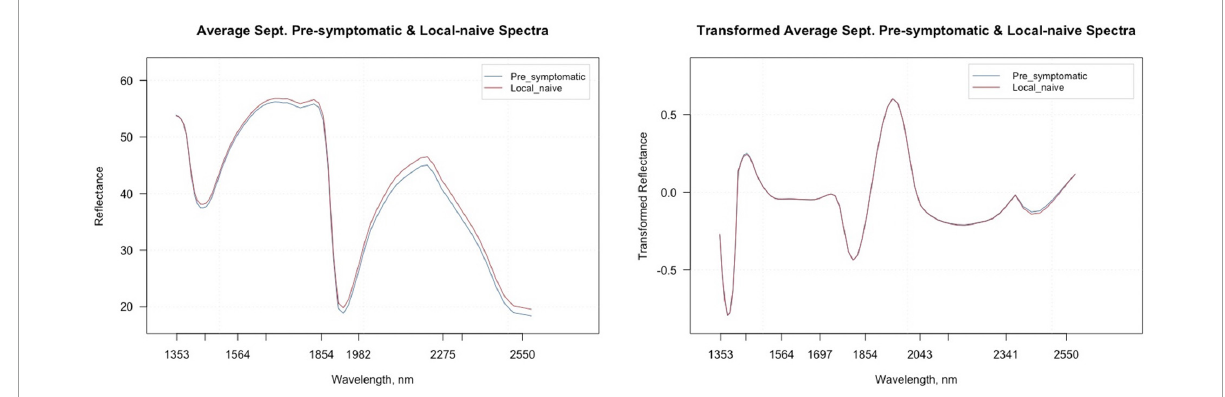
FIGURE5 Average raw and second derivative transformed spectral signatures of pre-symptomatic samples from only the Kiwanis site and local-naïve samples in September.